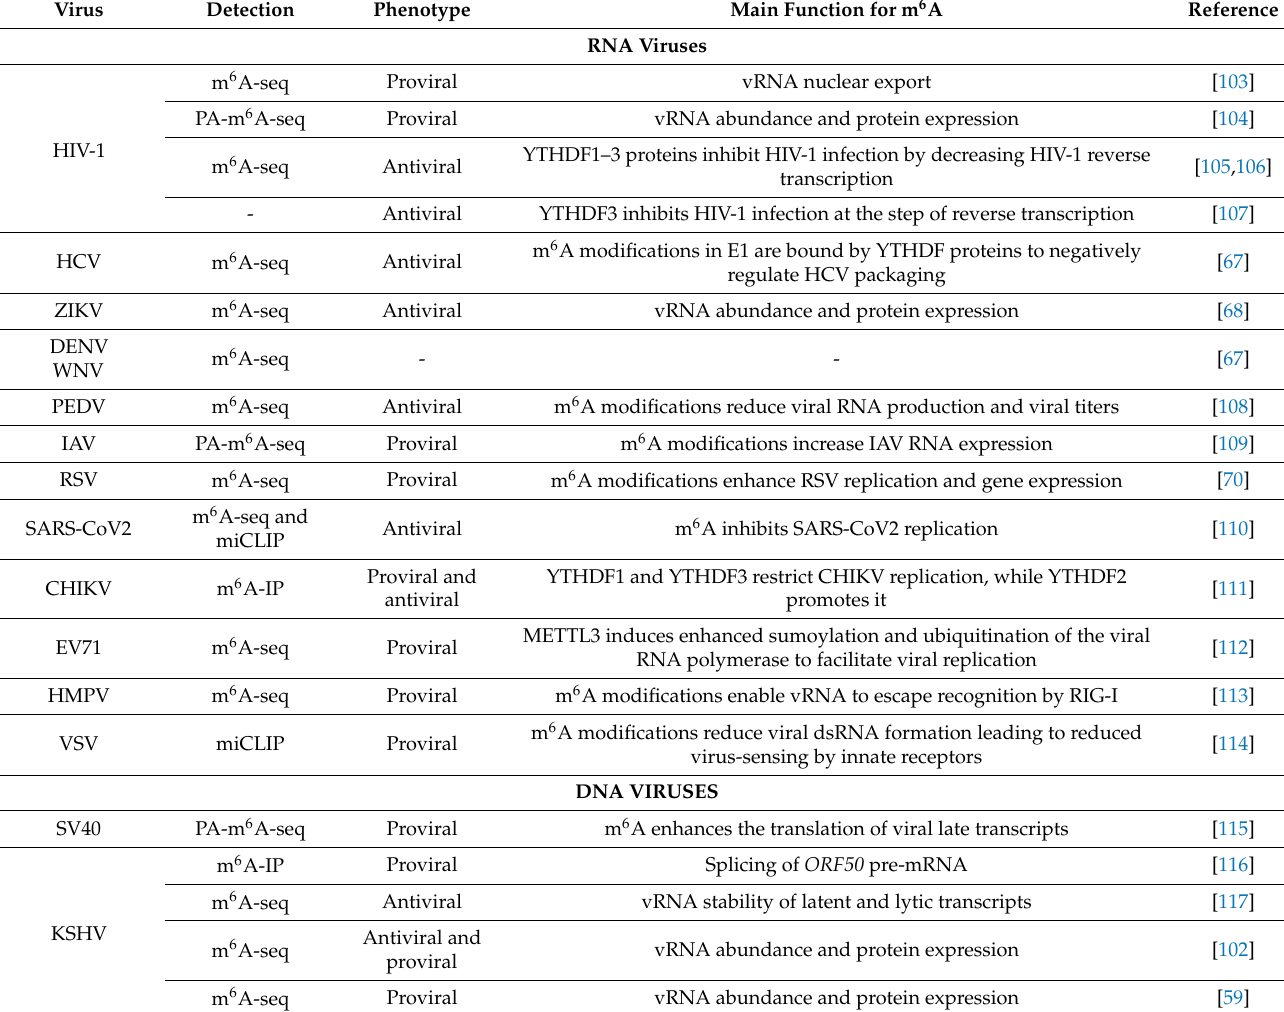
Table 1. Literature on viral m 6 A epitranscriptomic